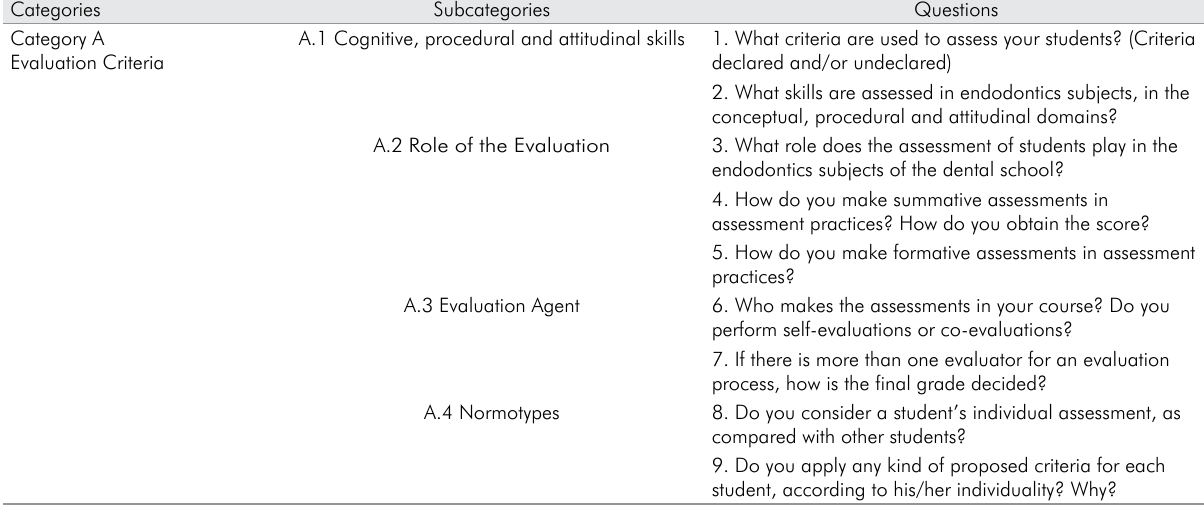
Table 1. Example of Instrument: Questions made by the interviewer to teachers in Category A.